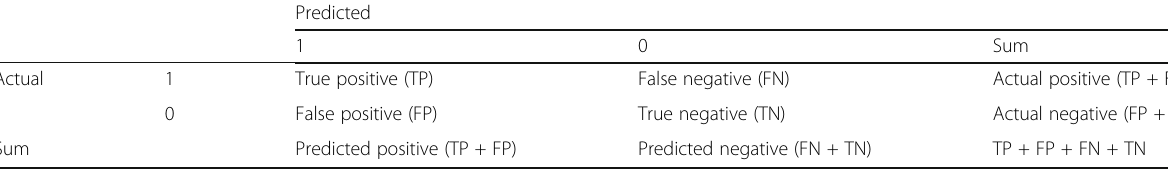
Table 1 The evaluation index of receiver operating characteristic (ROC)